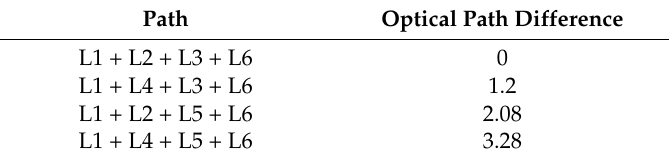
Table 2. Optical path difference of the MI with no scanning mirror in the sensing arm.